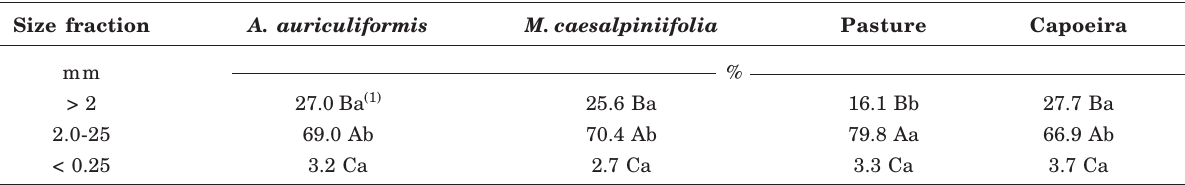
(1) Averages followed by the same uppercase letters in the column (comparing size fraction in each cover) and averages followed by the same lowercase letters in the row (comparing different covers in each size fraction) are not significantly different by Tukey’s test at 5 %.